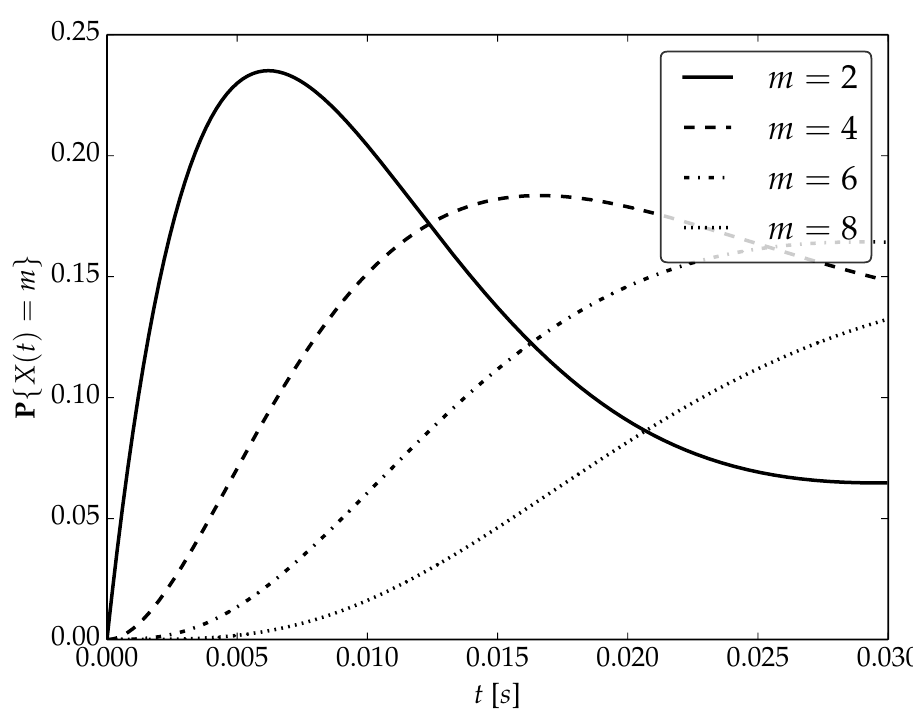
Figure 10. Transient distributions P { X ( t ) = m } for N = 6, batch distribution P 1 and ρ = 1.